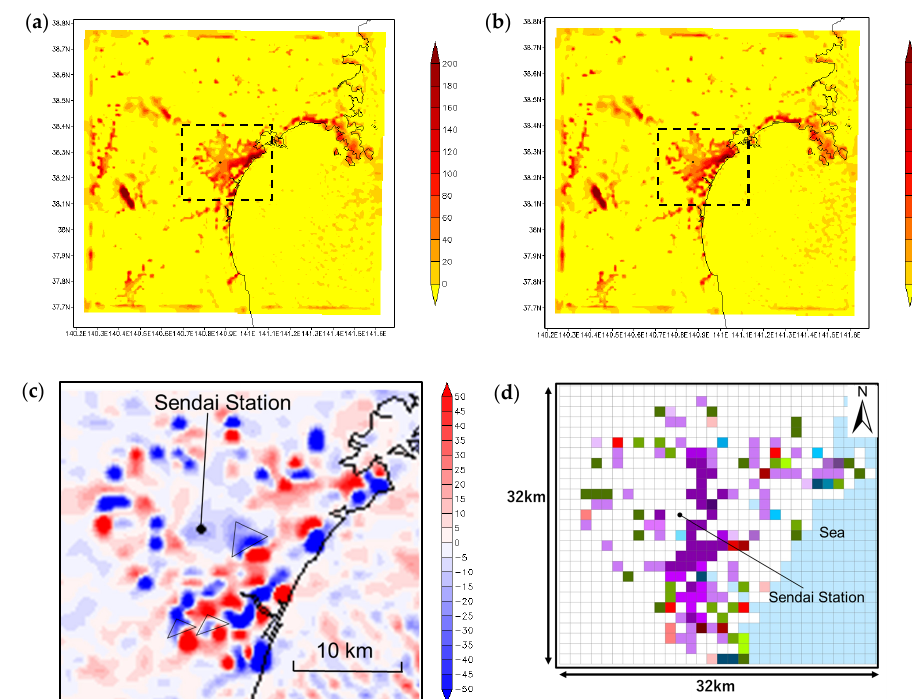
Figure 10. Distributions of the advection component of sensible heat balance {MW} in the daytime. ( a ) In Case lu_2002; ( b ) in Case lu_2022; ( c ) changes in the advection component of sensible heat balance (between Case lu_2022 and Case lu_2002); and ( d ) land use changes between 2002 and 2022 in Sendai (reposted Figure 4).